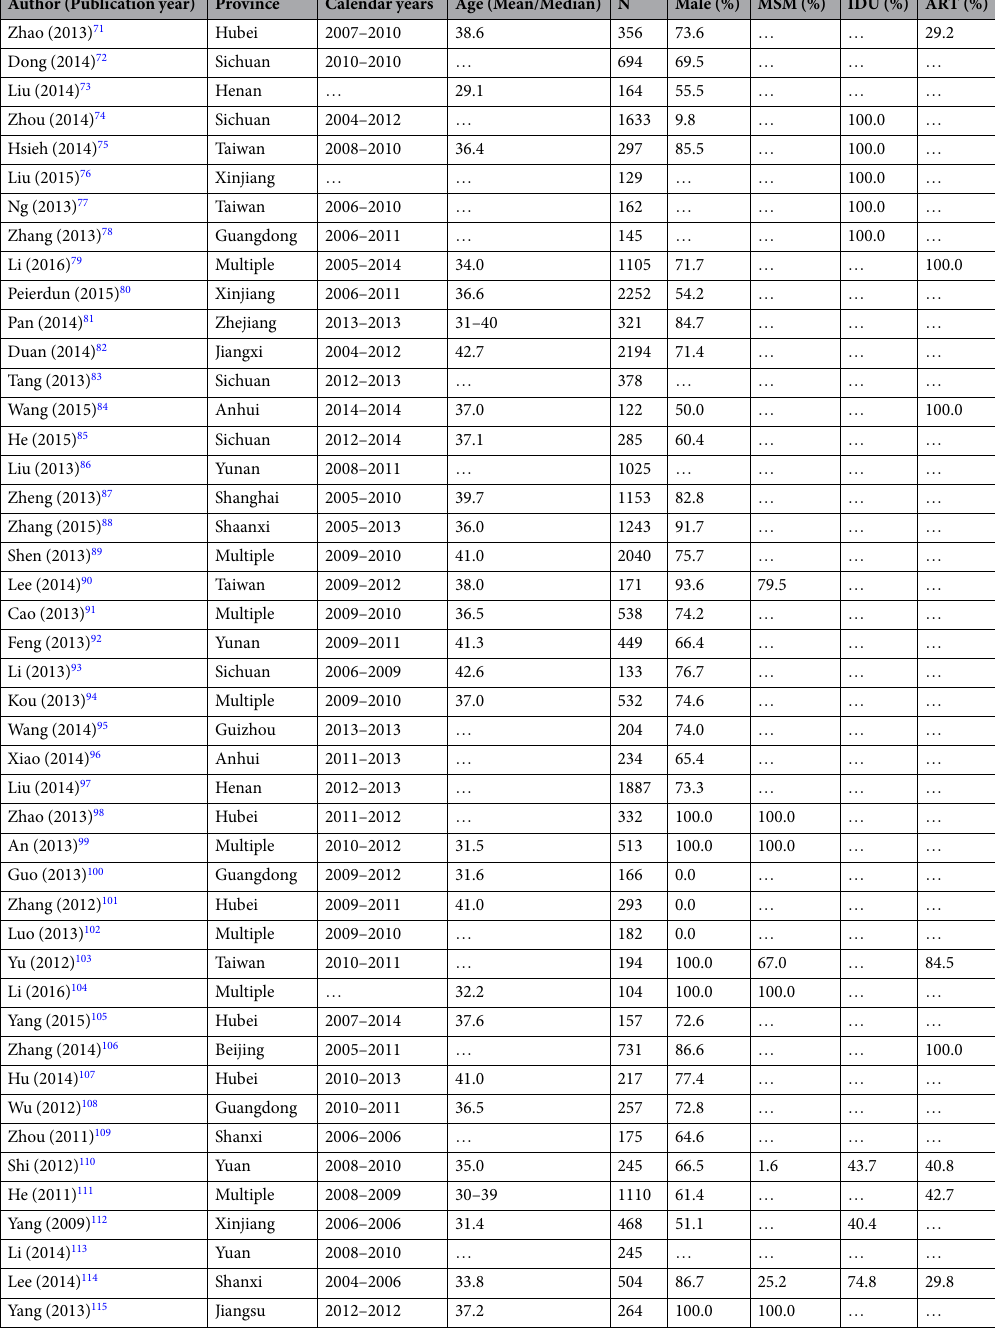
Table 2. Characteristics of eligible